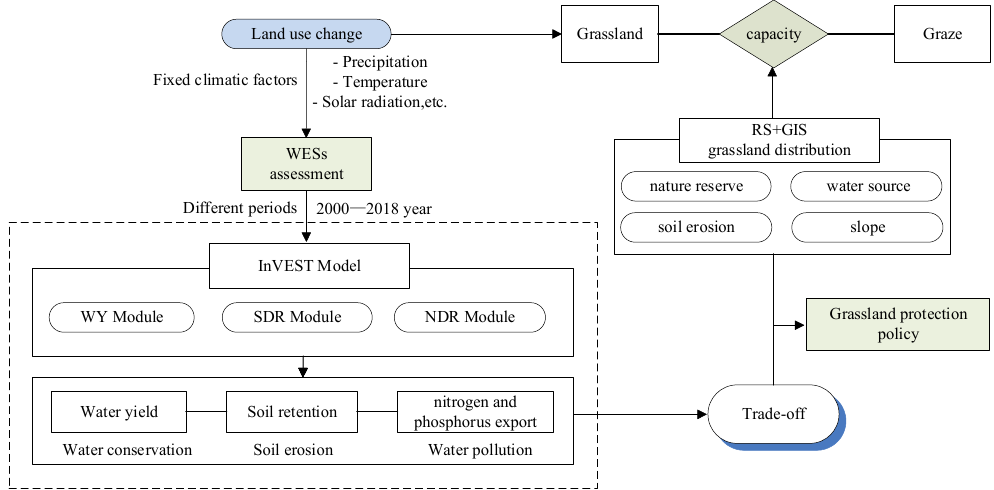
Figure 2. Methodological framework applied in the present analysis. WY = water yield; SDR = sediment delivery ratio; NDR = nutrient delivery ratio).